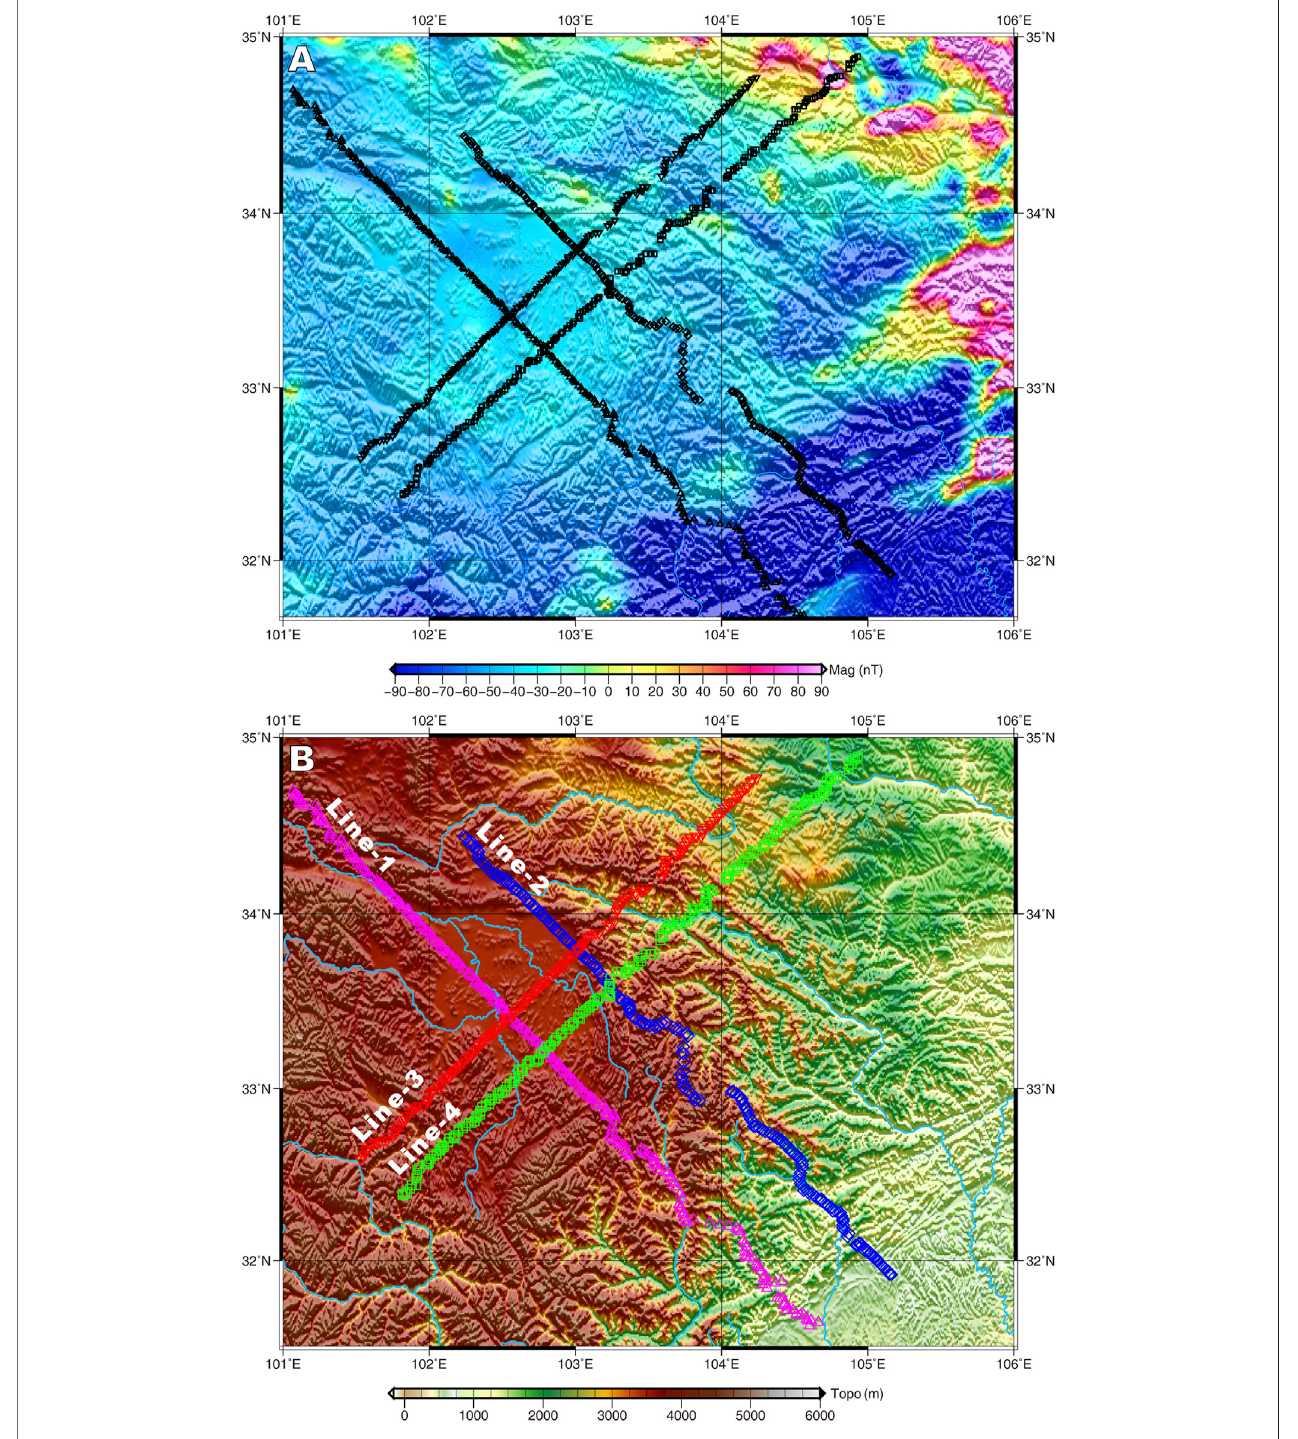
FIGURE 2 | Magnetic anomalies in study area (A) and Magnetotelluric survey lines (B) (pink triangle is Line 1, blue square is Line 2, red triangle is Line 3 and green square is Line 4).